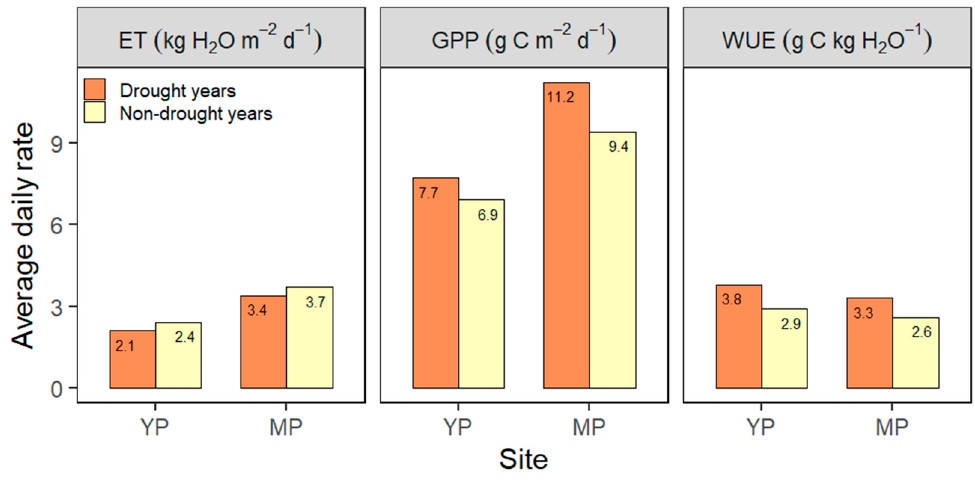
Figure 8. Daily average evapotranspiration (ET), gross primary productivity (GPP), and water use efficiency (WUE) at YP and MP. Daily values during the growing season (April–September) were averaged during 2007 and 2008 (drought years) and the rest of the years (non-drought years). Colored bars represent the drought and non-drought